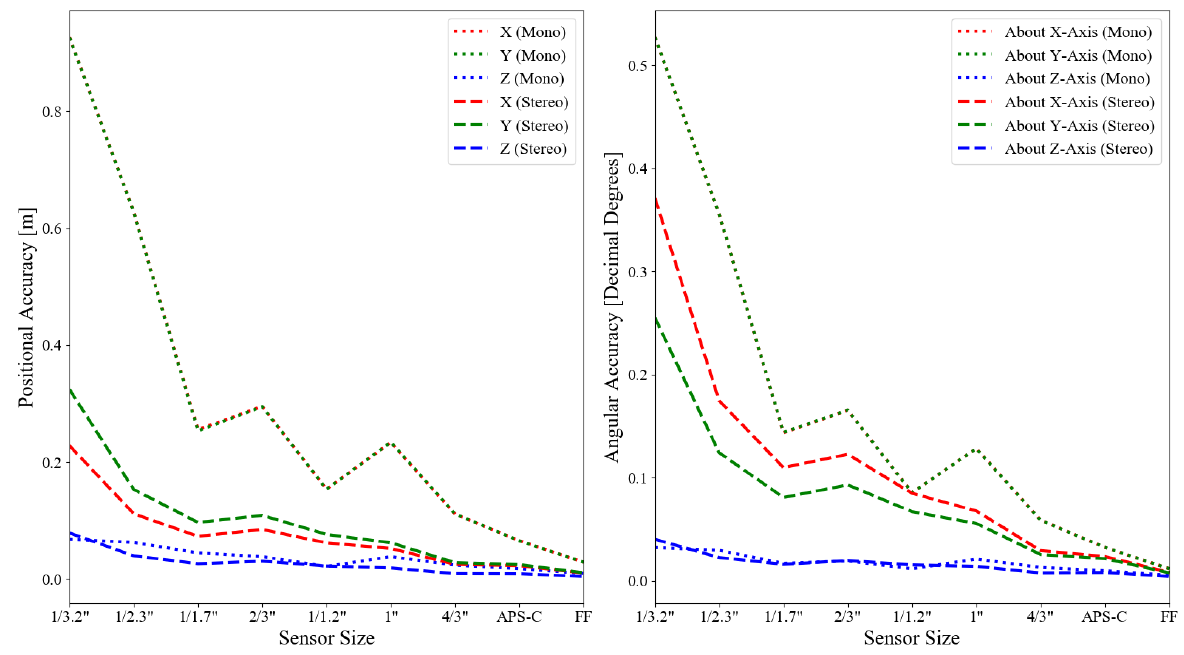
Figure 4: Sensor size implications on pose accuracy for monocular and stereo vision sensors